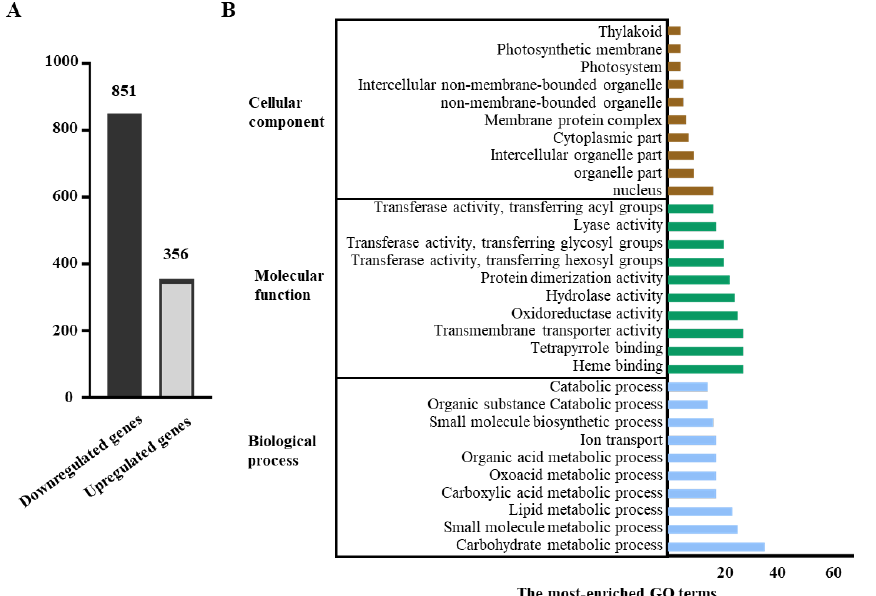
Figure 3. Differentially expressed genes in WT (14–345) and slf leaves. ( A ) Total numbers of differen- tially expressed genes of WT and slf leaves; ( B ) GO classification of DEGs in WT and slf leaves. The X-axis represents the number of genes annotated into the GO terms, and the Y-axis represents the functional classification.